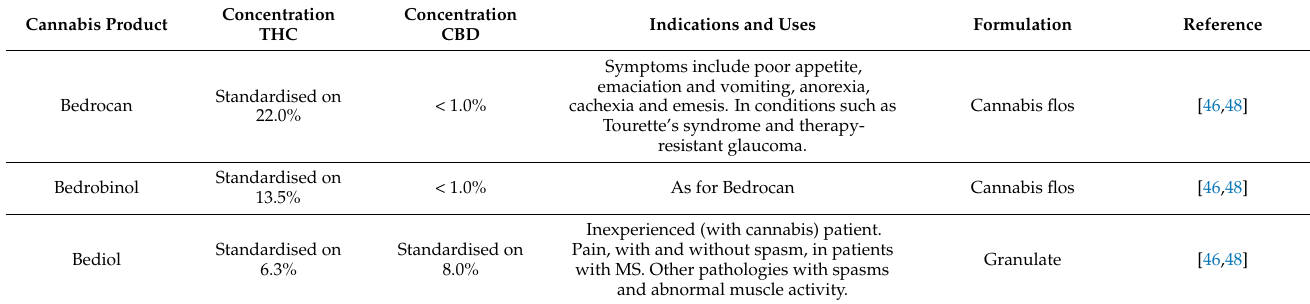
Table 1. Overview of approved (by national health authorities worldwide) cannabis products with information about the content of THC and CBD and the corresponding indications and